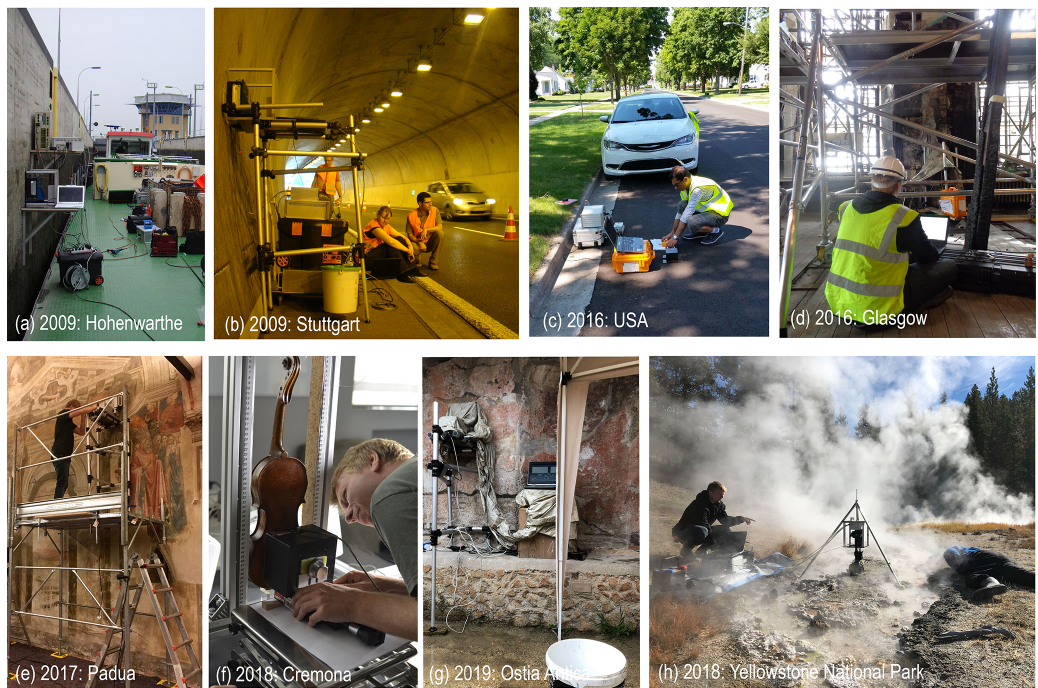
Figure 5. The MOUSE outside the house. (a) Profiling the moisture content of the gray concrete wall of the Hohenwarthe lock. (b) Profiling moisture in the concrete wall of the Gäubahn tunnel near Stuttgart. (c) Analyzing the crumb-rubber content in asphalt pavement (photo: Yadoallah Teymouri). (d) Assessing the fire damage of sandstone in the Mackintosh library of Glasgow. (e) Searching for a hidden Giotto fresco in Padua. (f) Measuring a depth profile though the back of a Stradivari violin in Cremona. (g) In search for a hidden wall painting in Ostia Antica on a rainy day. (h) Profiling sediment-covered biofilms at the hot springs in Yellowstone National Park.